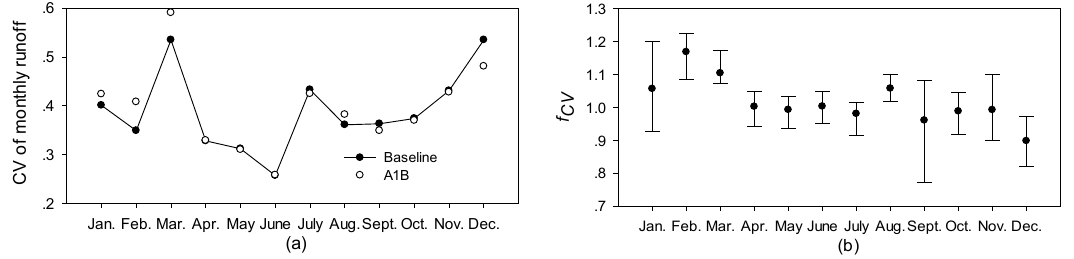
(a) Fig. 5 Changes in monthly runoff SD in the Wuxuan watershed: (a) comparison between the baseline and A1B monthly runoff SDs; and (b) monthly runoff-change statistic f SD with its 95% CI.